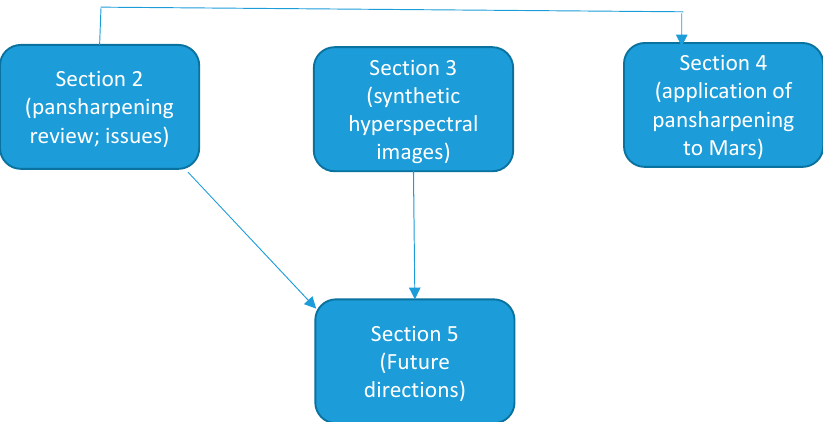
Figure 1. Relationships between the different sections in the revised paper.